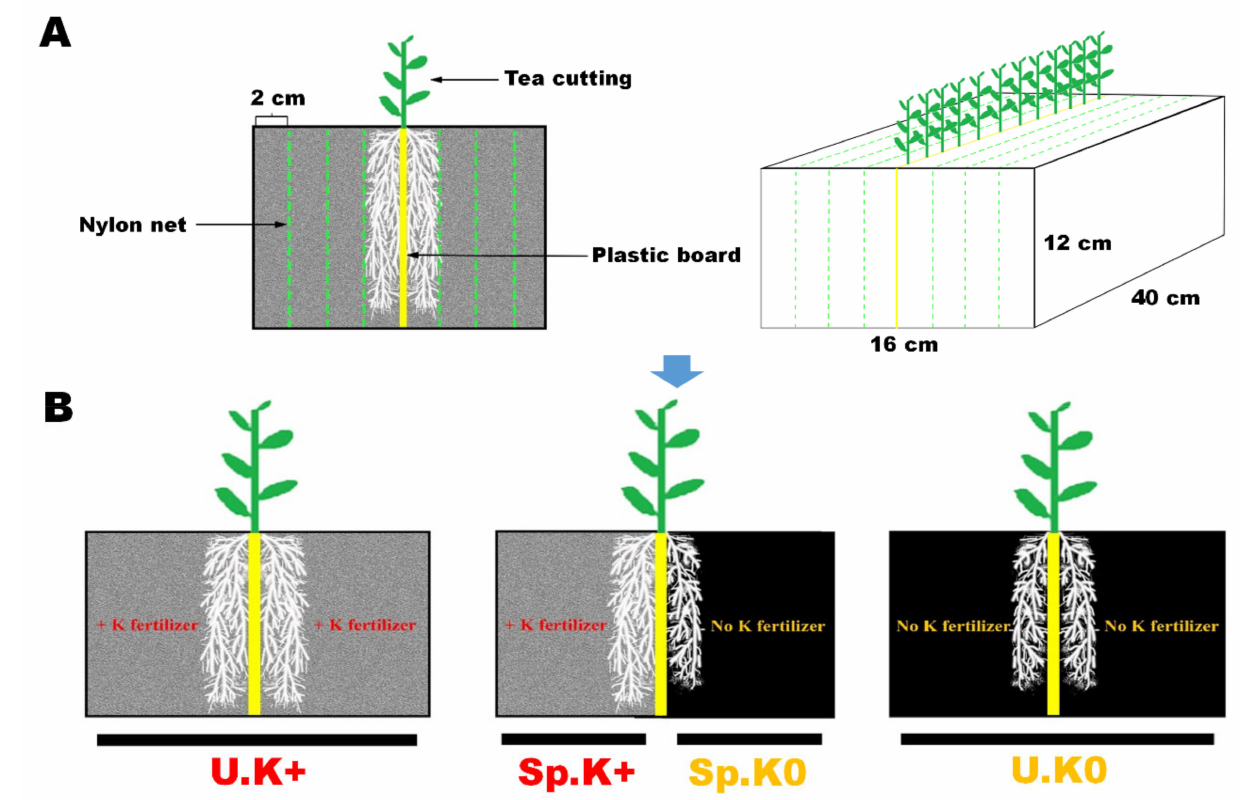
Figure 1. Multi-layer split-root box and treatments. Multi-layer split-root system ( A ). Treatments of heterogeneous and homogeneous K environments ( B